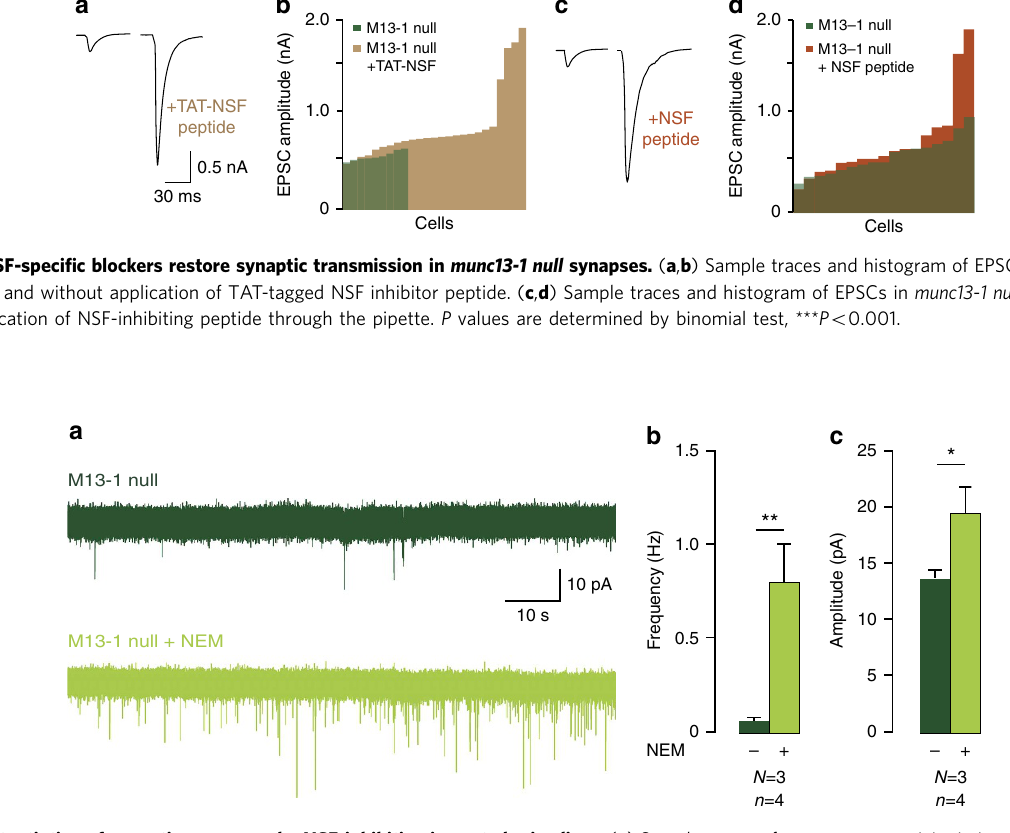
Figure 5 | Potentiation of synaptic responses by NSF-inhibition in acute brain slices. ( a ) Sample traces of spontaneous activity in immature synapses of newborn hippocampal slices of munc13-1 null mice with/without NEM (100 m M). ( b , c ) Quantification of mEPSC frequency and amplitude, N ¼ 3, n ¼ 4. Data in this figure are means ± s.e.m. * P o 0.05, ** P o 0.01, P value are determined by paired t